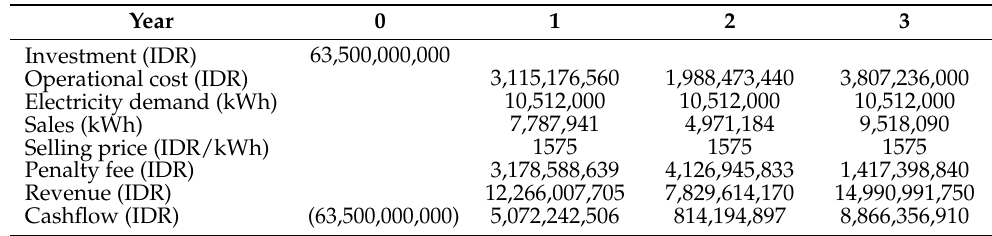
Table 5. Biogas plant’s cashflow from 2018 to 2020.